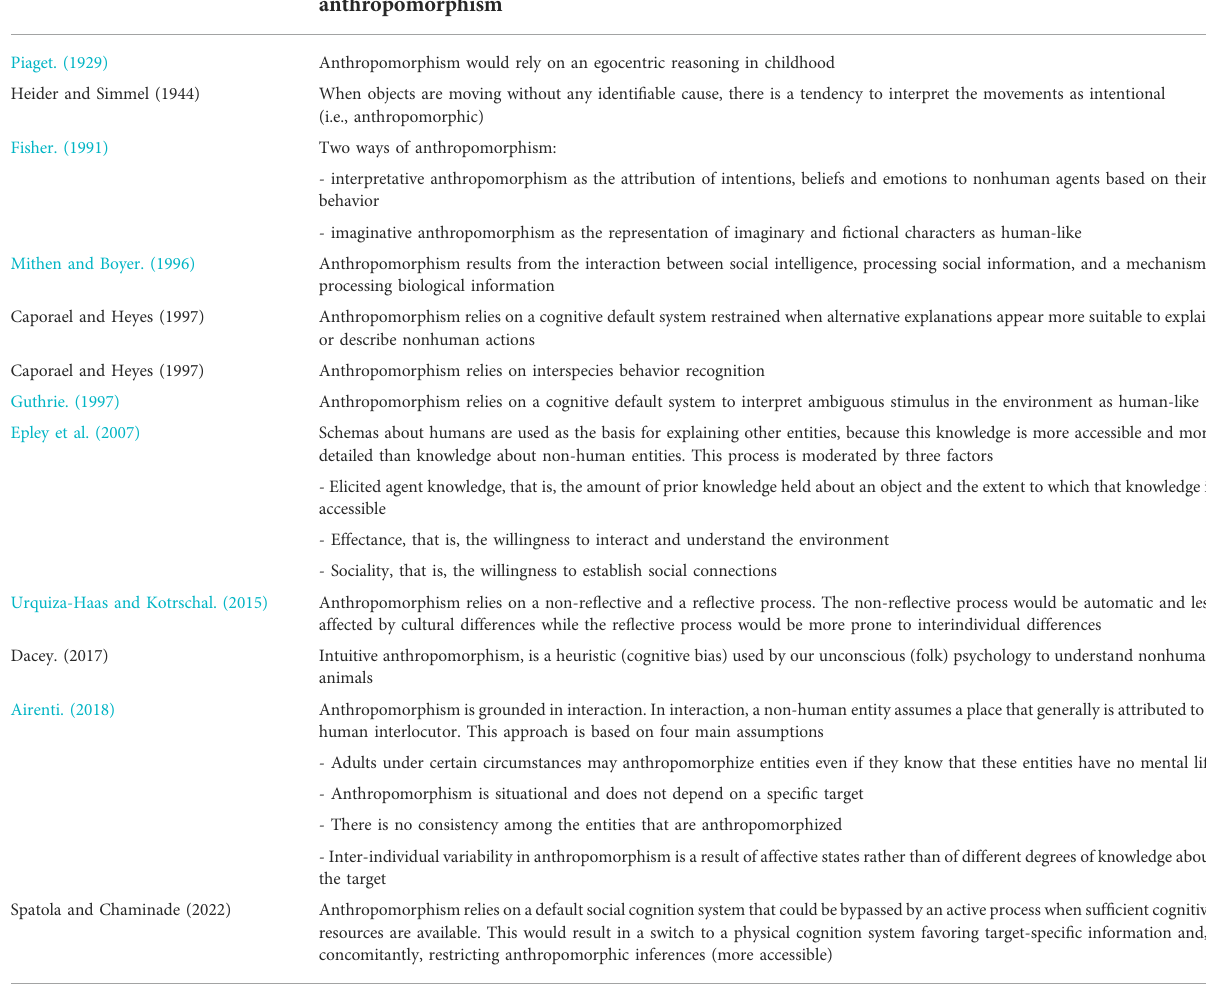
TABLE 1 Conceptualization of anthropomorphism across